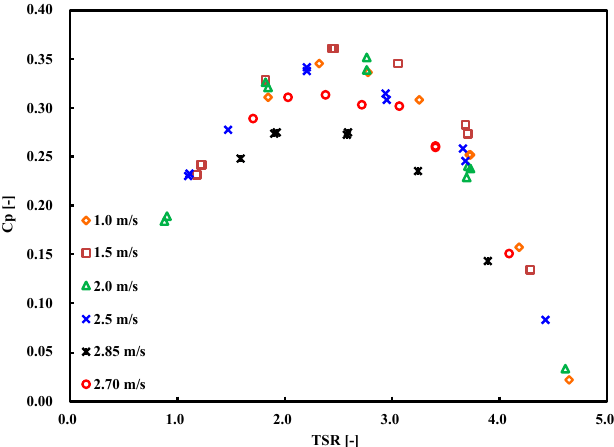
Figure 1. Schematic diagram of 0.35 m diameter test section at West Japan Fluid Engineering Laboratory Co., Ltd.